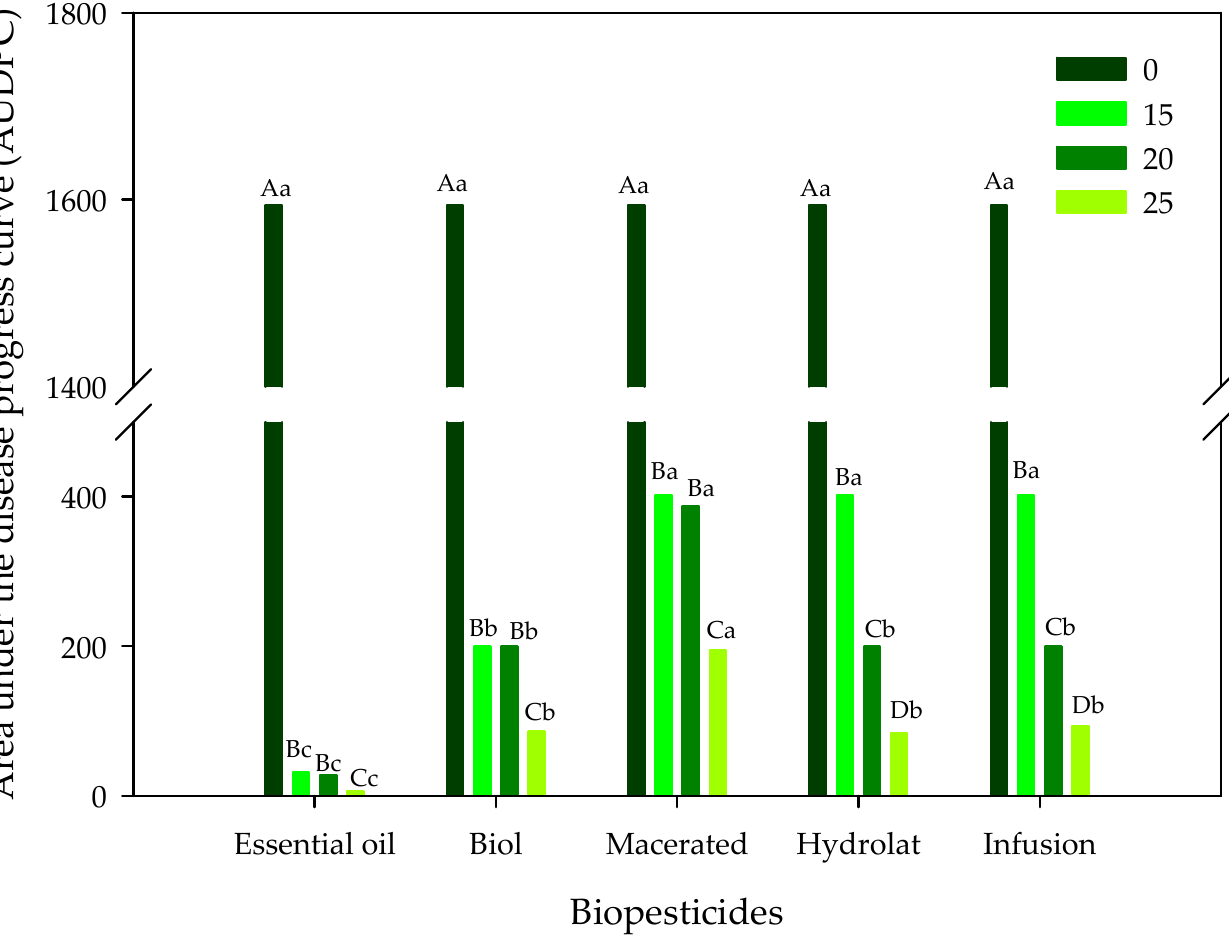
Figure 4. Comparison of means in relation to the area under the disease progress curve (AUDPC) when five biopesticides were applied at four concentrations. Uppercase letters for the comparison of doses and lowercase letters for the comparison of biopesticides represent significant differences using Tukey’s test at 5% probability.